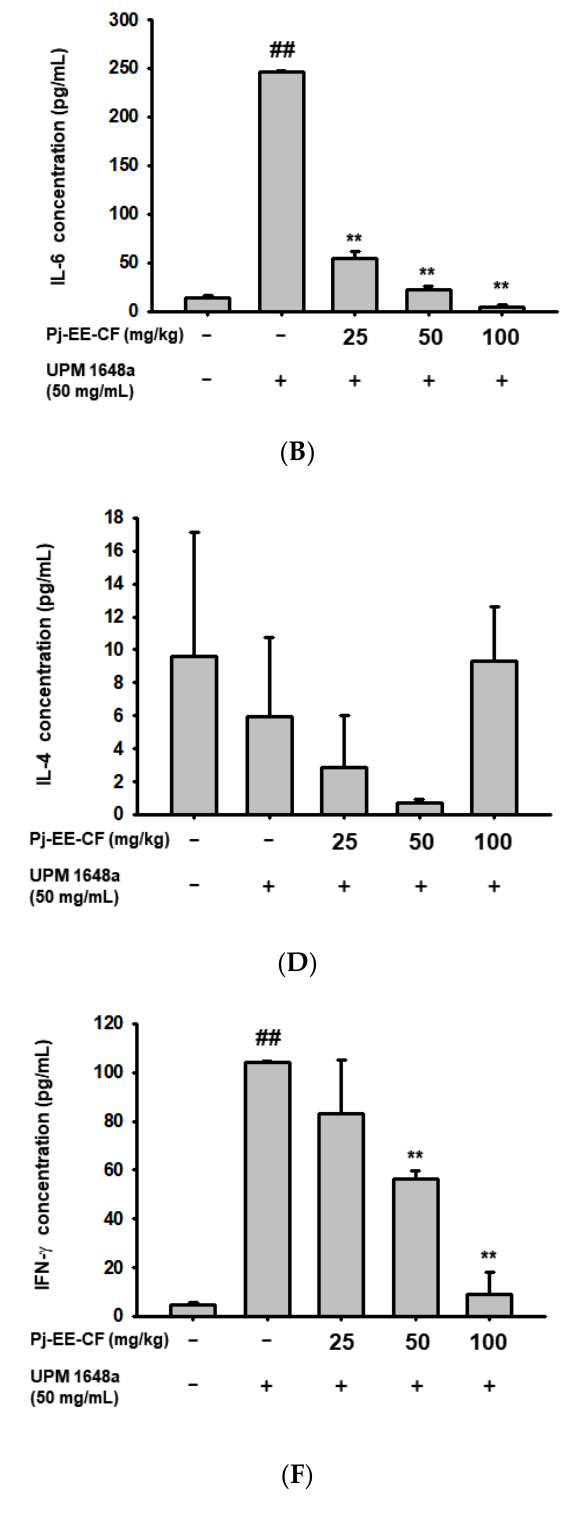
Figure 3. Inflammatory cytokine levels in BALF after UPM 1648a instillation and Pj-EE-CF administration in mice. IL- 1β ( A ), IL-6 ( B ), TNF- α ( C ), IL-4 ( D ), IL-12 ( E ), and IFN- γ ( F ) concentrations were determined by ELISA with BALF, using the same amount of protein as adjusted with PBS. All data are presented as mean ± SD of five biological replicates (n = 5 mice/group). # p < 0.05 and ## p < 0.01 compared to normal (non-treatment), * p < 0.05 and ** p < 0.01 compared to control (UPM 1648a alone).